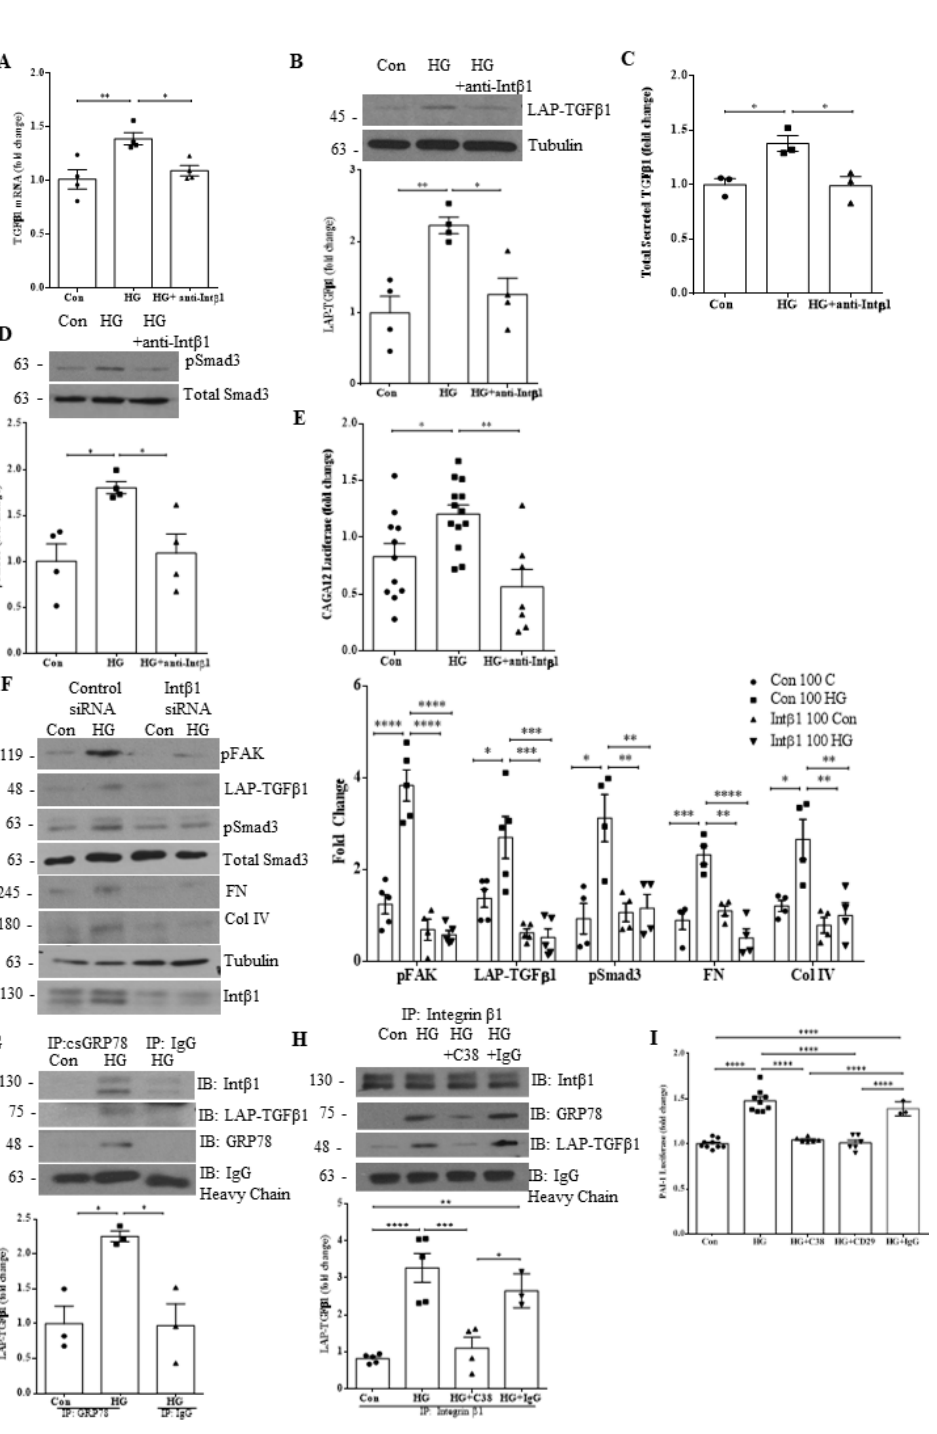
Figure 4. Integrin β 1 interaction with csGRP78 is required for TGF β 1 upregulation and signaling in HG. HG-induced TGF β 1 ( A ) transcript upregulation ( n = 4), ( B ) protein synthesis ( n = 4), ( C ) secretion ( n = 3) and signaling measured as ( D ) Smad3 activation (phosphorylation at Ser473/475) ( n = 4) or ( E ) CAGA12 luciferase activity ( n = 12) were inhibited by a neutralizing integrin β 1 antibody (10 µg, HG 24h for mRNA and 48 h for all others, * p < 0.05, ** p < 0.01). ( F ) These were also prevented by downregulation of integrin β 1 using siRNA, which also inhibited activation of the integrin-regulated kinase FAK (phosphorylation at Tyr397) and upregulation of matrix proteins fibronectin (FN) and collagen IV (Col IV) in response to HG (48 h, n = 6, * p < 0.05, ** p < 0.01, *** p < 0.005, **** p <